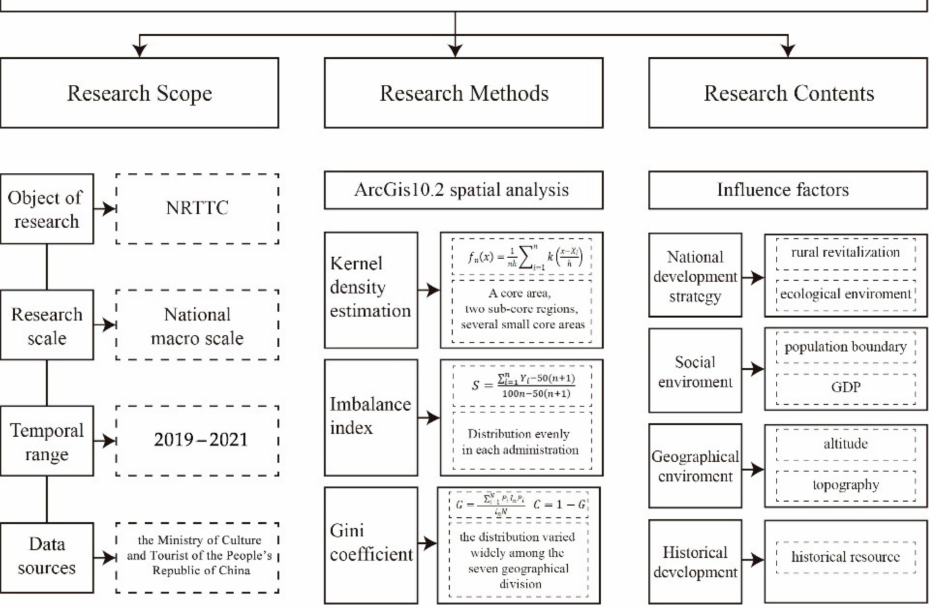
Figure 12. Main research